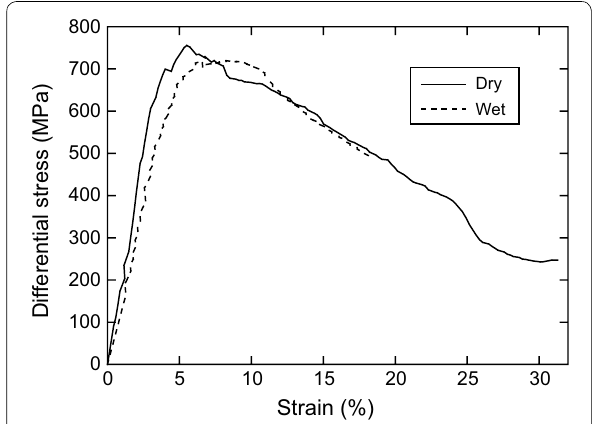
Fig. 3 Stress–strain curve for the dry (solid line) and water‑added (dashed line) axial deformation